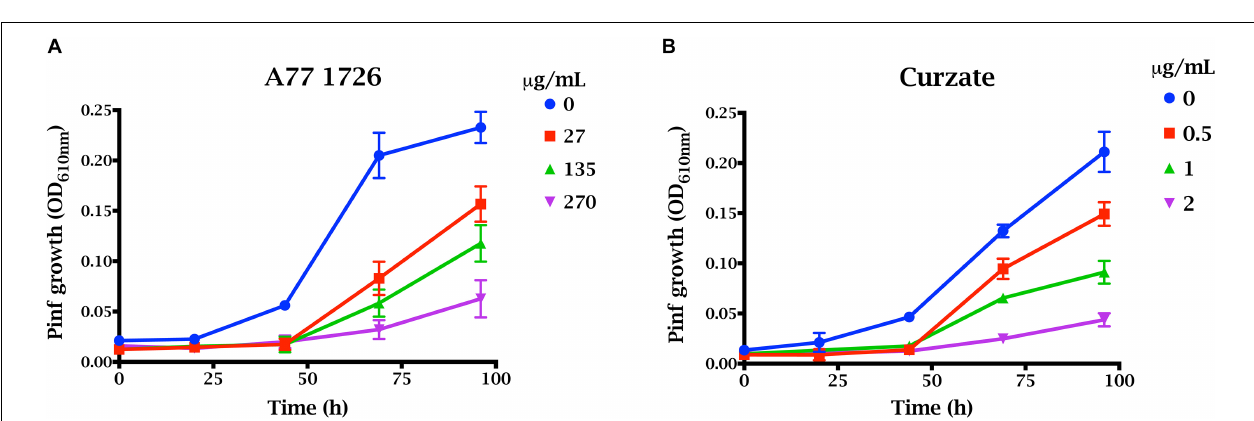
FIGURE 5 | Effect of A77 1726 on the growth of P. infestans . Growth of zoospores and sporangia were evaluated by OD 610 nm for 100 h in the presence of (A) 0, 27, 136, 277 µ g/mL (0, 0.1, 0.5, and 1 mM) A77 1726, or (B) 0, 0.5, 1, and 2 µ g/mL Curzate.